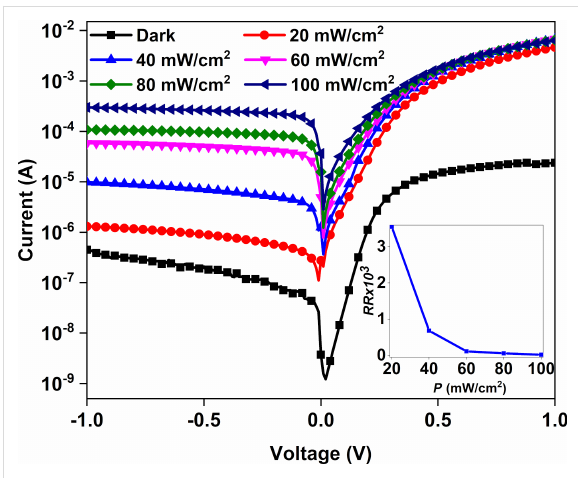
Figure 4: The I – V characteristics as well as RR changes of the Au/CuNiCoS 4 /p-Si photodiode under different illumination